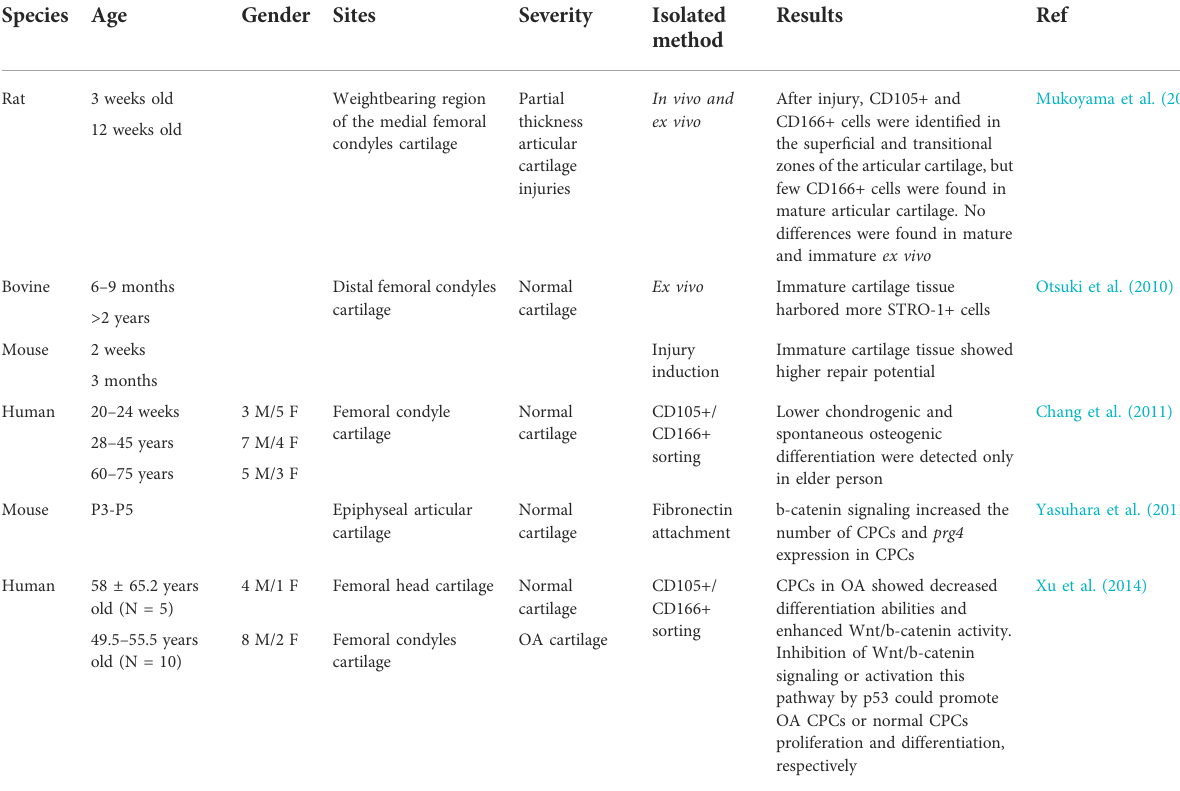
TABLE 2 CPCs in immature, mature and elder cartilage.